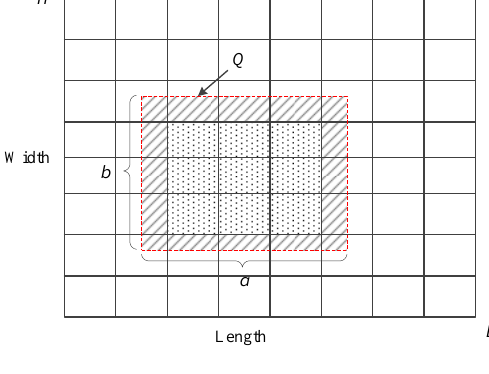
Figure 2. Example of data